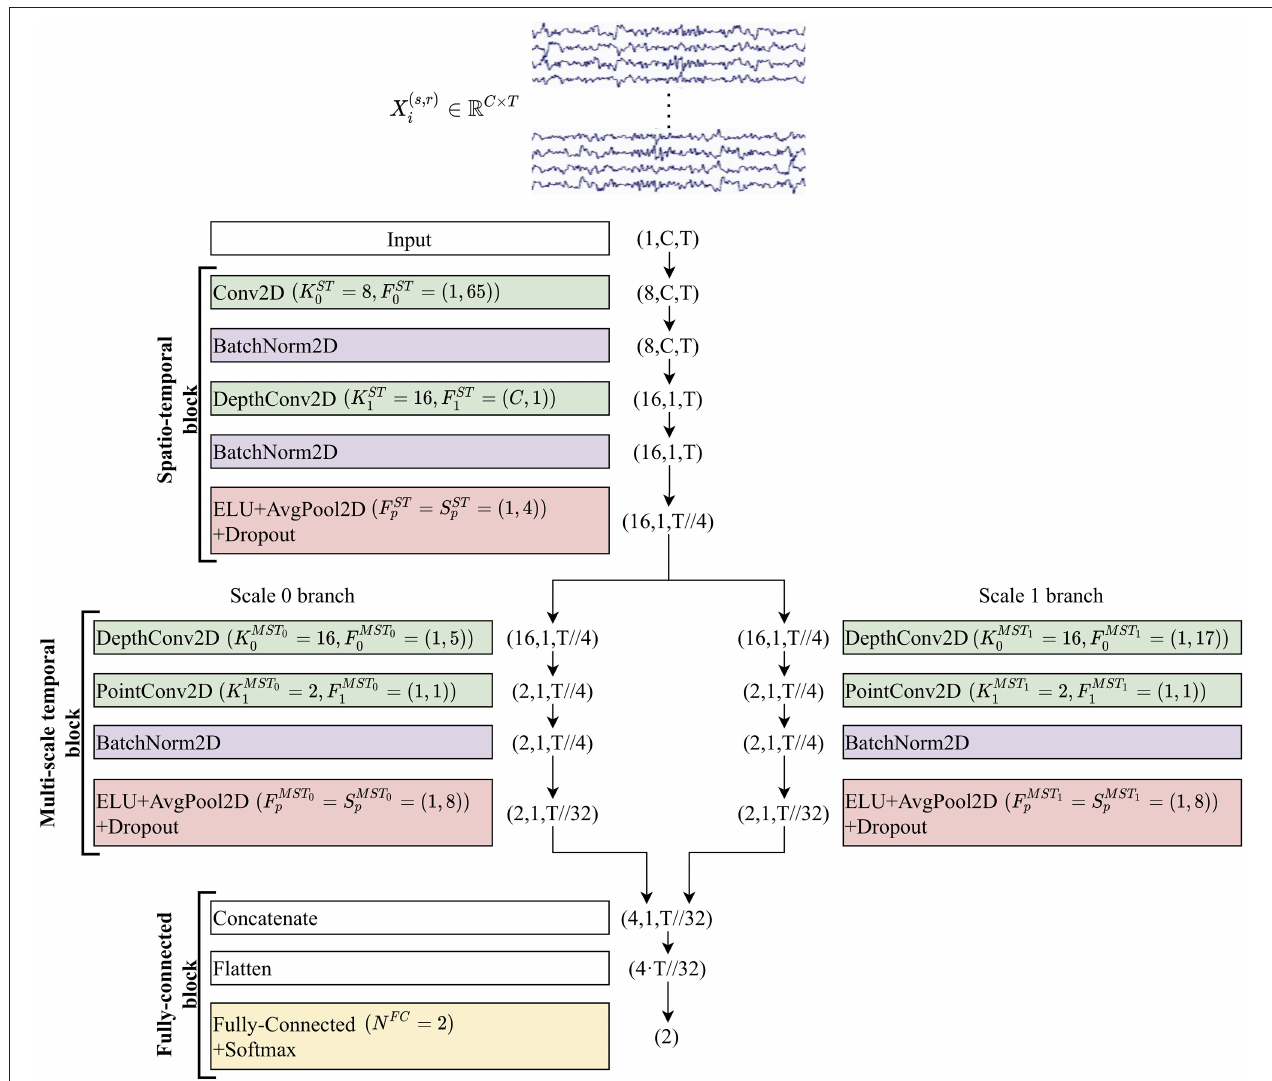
FIGURE 1 | Structure of MS-EEGNet. Layers are represented by colored rectangles, reporting the layer name and main hyper-parameters. The tuple outside each rectangle represents the output shape of each layer. For all outputs except the last two (Flatten and Fully-connected + Softmax), the tuples are composed of three numbers representing the number of feature maps (channel dimension), number of spatial samples, and number of temporal samples within each map. The input layer provides an output of shape 1, C , T , as it just replicates the original input matrix with shape ( C , T ), providing a single feature map as output. The temporal dimension (cid:0) (cid:1) changed from T to T // 32 along the entire CNN (where the symbol // indicates the floor division operator) due to average pooling operations. See sections EEG Decoding via CNNs and The Proposed Convolutional Neural Network and Its Variants for the meaning of symbols, and see Table 1 for further